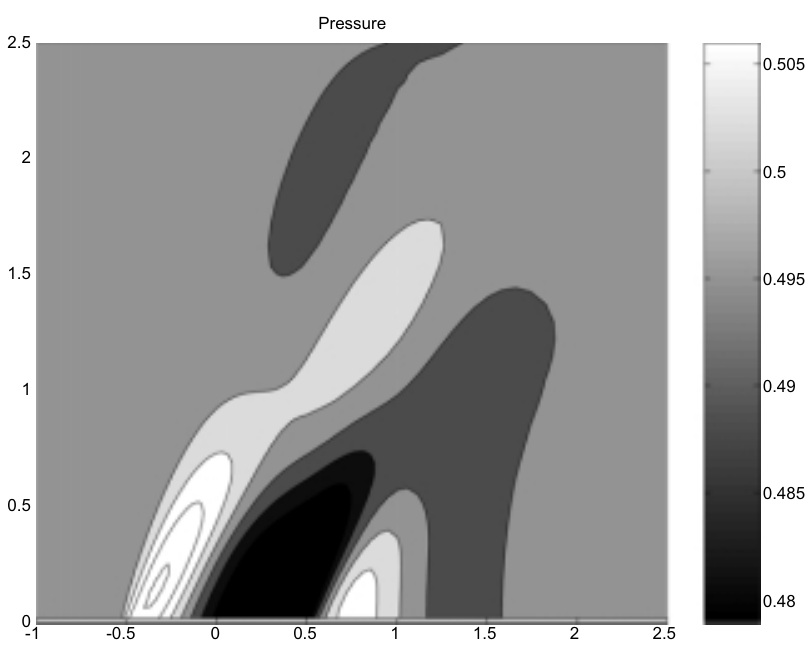
Fig. 23. Pressures after 20 second simulation using 16 modes with δ 1 = 0 . 01 .